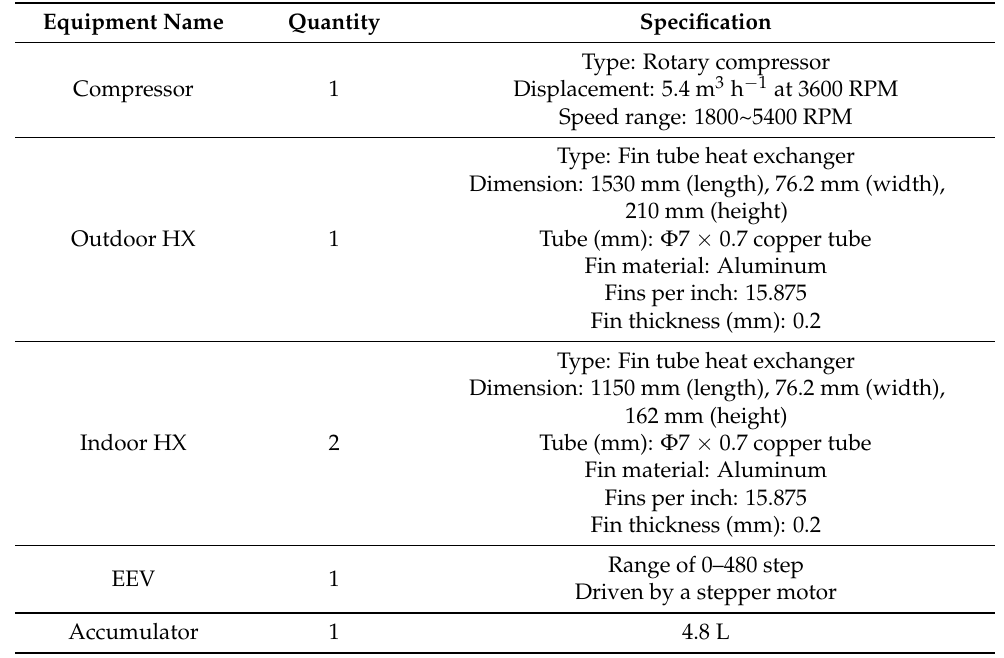
Table 1. Specifications on system